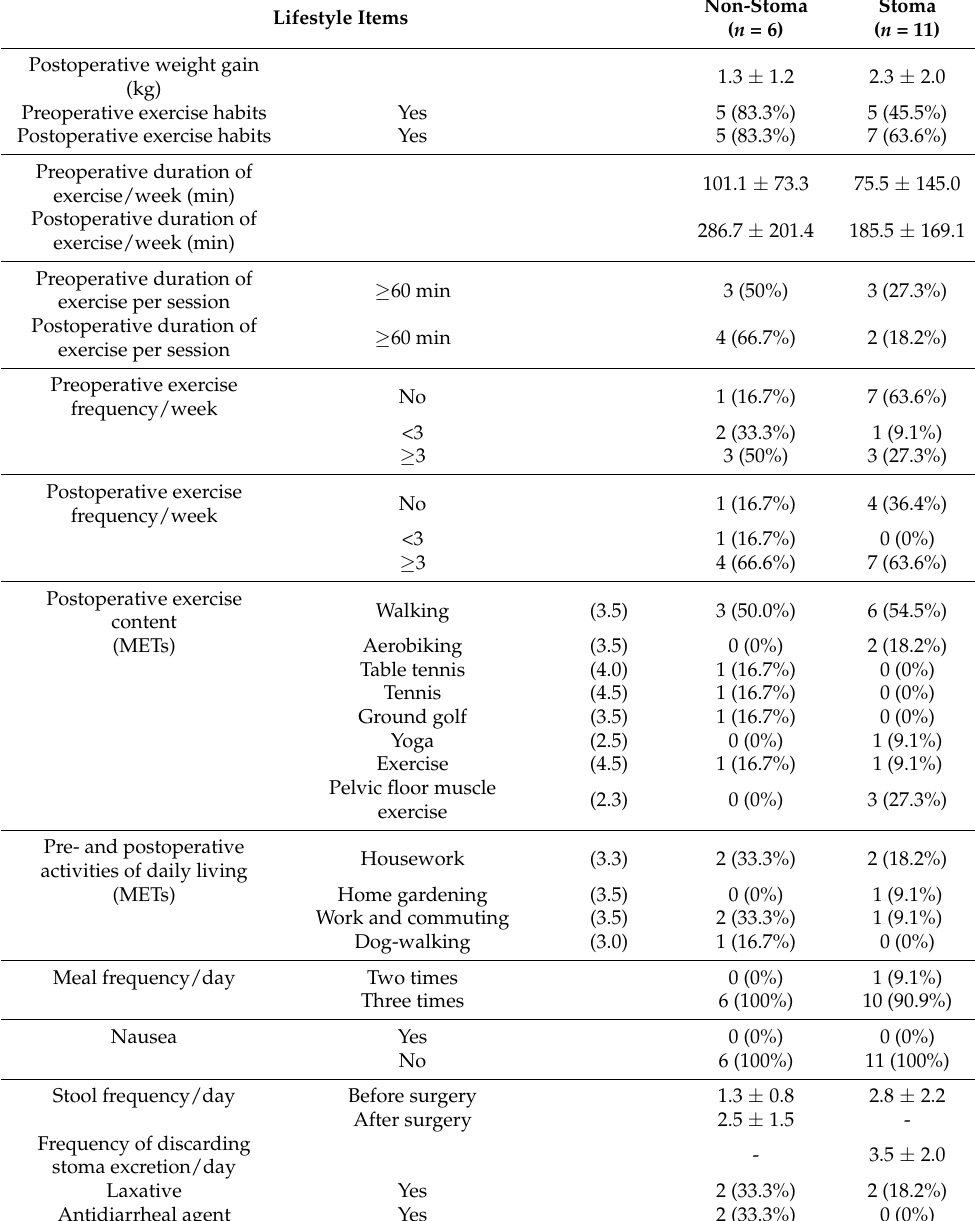
Table 2. Overview of pre- and postoperative